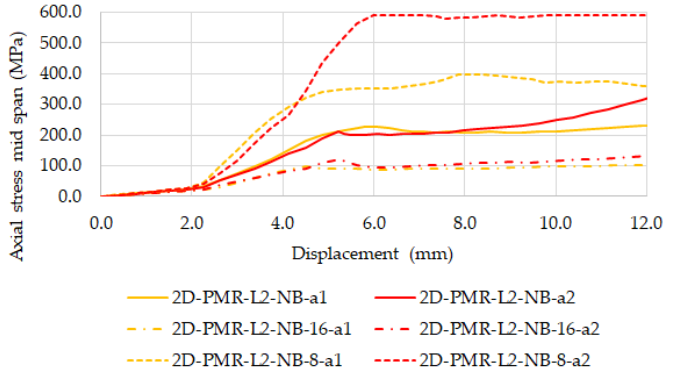
Figure 22. Axial stress at the steel connectors’ mid-span versus the plate vertical displacement diagram for 2D-PMR models with two levels of reinforcement without a bond assumption: connector diameter